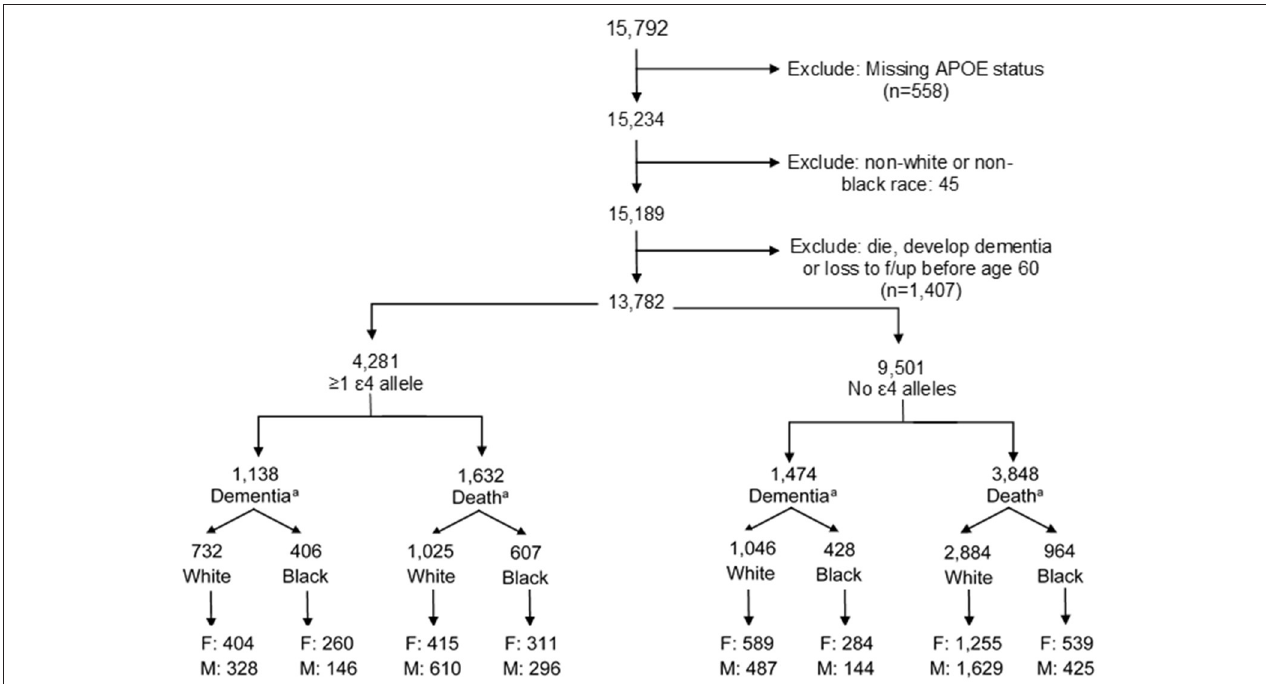
FIGURE 1 | Creation of analytic study sample. F, female; M, male. a Final dementia or death numbers by ε 4 status and stratification by males and females indicate the number of participants who experienced a dementia diagnosis or dementia-free death. Numbers do not add up to the total by ε 4 allele status due to those participants who were censored at the end of study follow-up alive and without